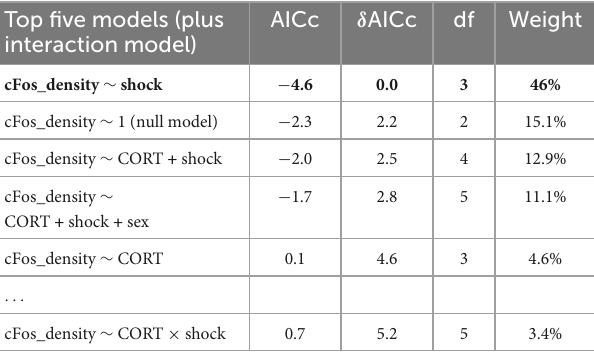
TABLE 2 Model selection for the effect of history of footshock (shock), corticosterone treatment (CORT), and sex on c-Fos+ cell density in the basal